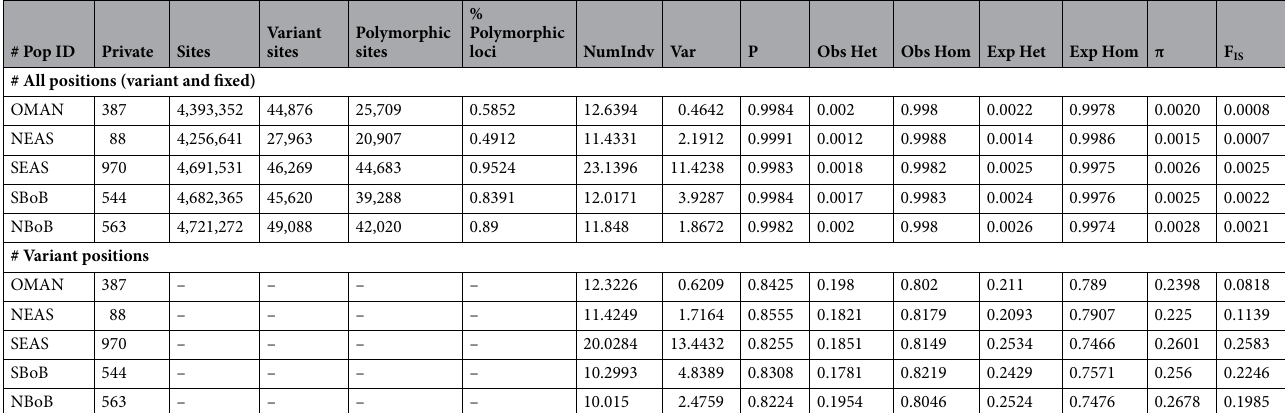
Genome-wide genetic diversity. The average frequency of major alleles (P) and average observed het- erozygosity (Ob Het) of both fixed and variable sites from five populations ranged from 0.998 to 0.999 and 0.0017–0.0020, respectively. Whereas for the variable sites, the p -value decreased to 0.85–0.82 and Ob Het increased to 0.178–0.198. The overall nucleotide diversity (π) in S. longiceps populations ranged from 0.0015 to 0.0028 and samples from the Oman Sea—OMAN (0.0020) and North Eastern Arabian Sea—NEAS (0.0015) had the lowest level of nucleotide diversity. The population of South-Eastern Arabian Sea—SEAS (0.0026), Southern Bay of Bengal—SBoB (0.0025), and Northern Bay of Bengal—NBoB (0.0028) had relatively high diversity when compared to OMAN and NEAS. All the five populations had unique (private) sites/alleles with the maximum in SEAS (970) and minimum in NEAS (387) (Table 1). In all the populations, the inbreeding coefficients (F IS ) of all restriction-site associated DNA (RAD sites) (vari- ant and fixed) ranged from 0.0007 to 0.0025 but these were higher for variant sites only (0.0818 to − 0.2583). The allele frequency spectrum of major alleles across the loci was skewed towards 1.00 and varied slightly across the populations (Supplementary Fig. S1). The highest percentage of allele frequency was observed in category one (rightmost category equal to 1.0 in the graph), indicating that most polymorphic loci across the population are fixed within each population. A lower range of allele frequencies (0.5–0.99) was observed in all the populations as expected for an older genetically diverse population at or near evolutionary equilibrium 39 . Genome-wide genetic differentiation. Oman population was highly differentiated from all the other populations (F ST /R ST value of 0.0789/0.07632, 0.0657/0.06627, 0.06979/0.06958 and 0.06791/0.06791 for the four pairwise comparisons), in comparisons of pairwise genetic differentiation (F ST and R ST ) (Table 2, Supplementary Fig. S2) with highly significant p -values (< 0.001). In all the other pairwise comparisons, the highest genetic dif- ferentiation was observed between the NEAS and NBoB followed by the SEAS and SBoB populations, but p -val- ues were not significant. The Oman population was also highly separated along PC1 in PCA plots as compared to other populations while the majority of the individuals of NEAS were separated from others along PC2 (Sup-